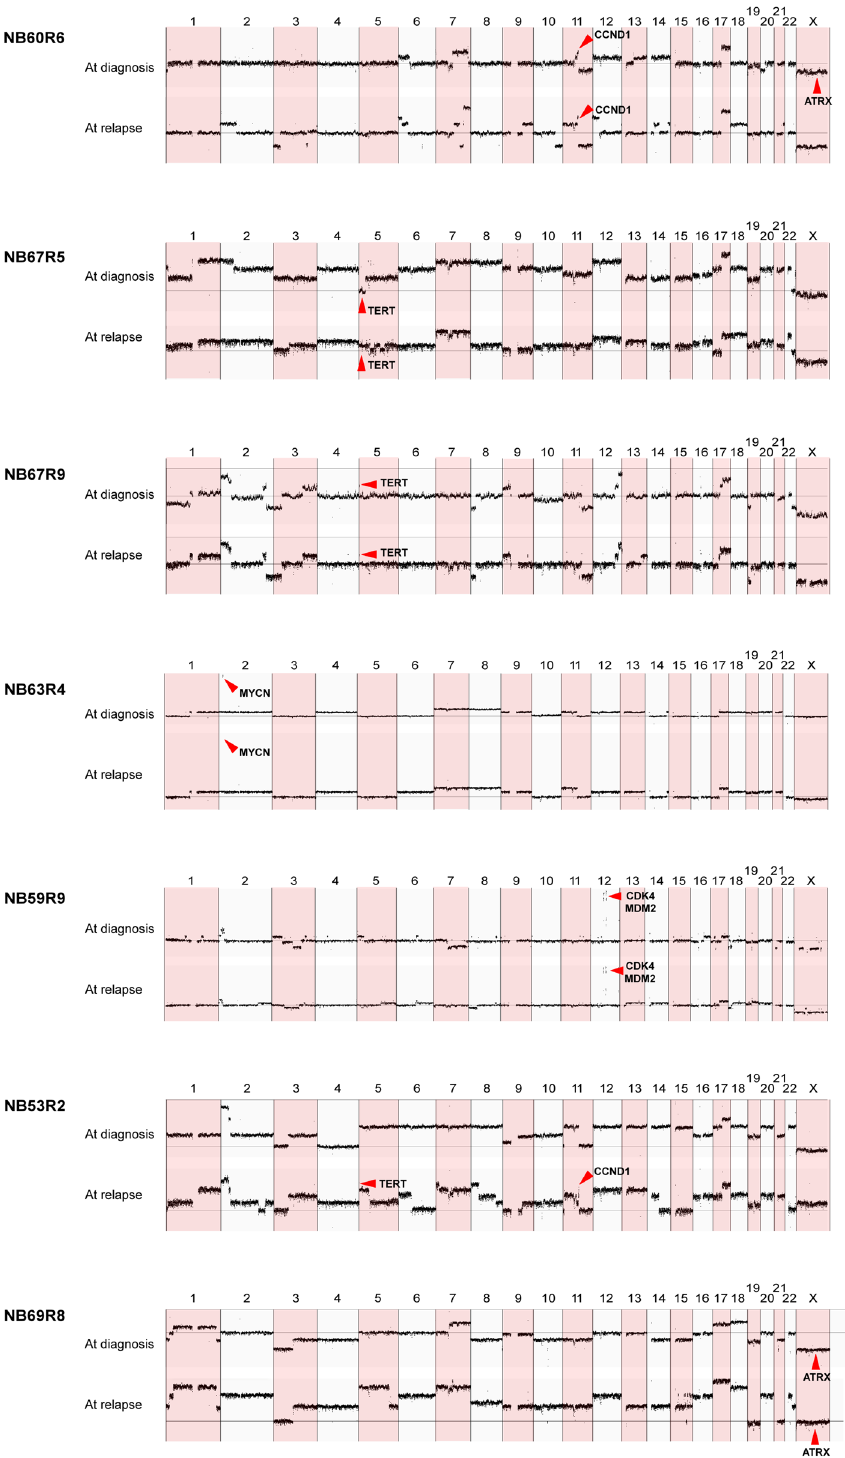
Figure 2. Copy number aberrations. Coverage-based plots displaying segmental alterations in primary and relapsed